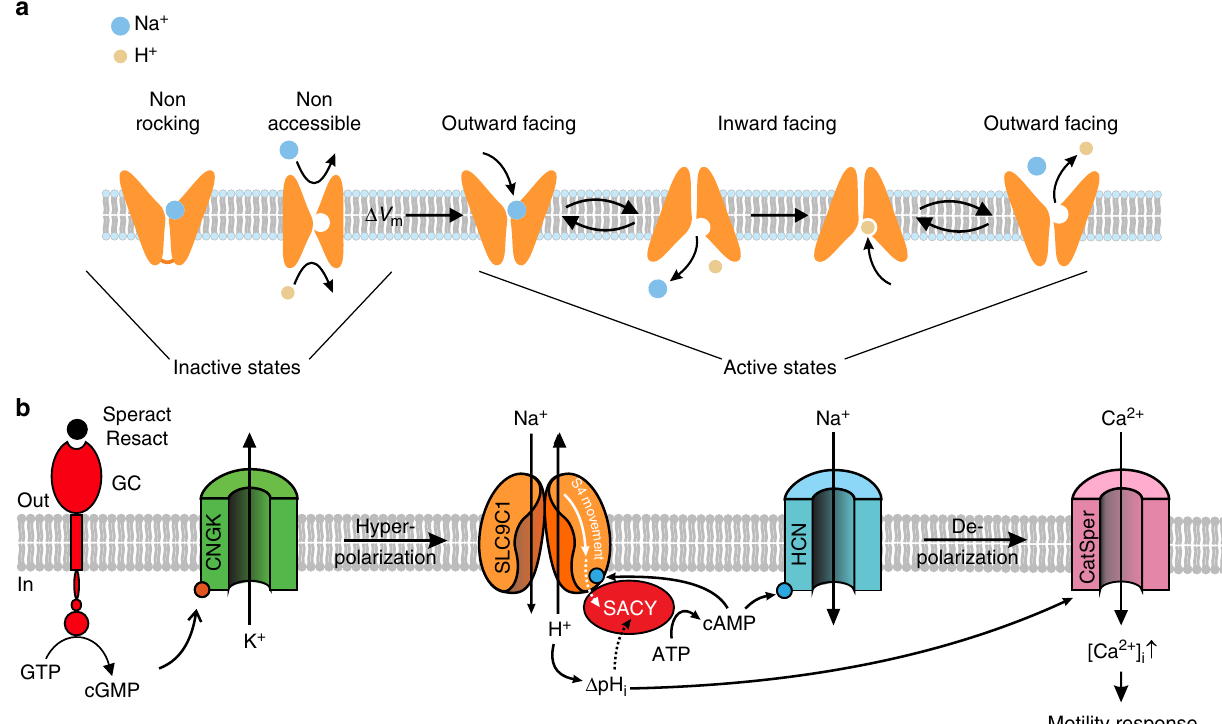
Fig. 7 Models of SLC9C1 gating by voltage and cAMP. a Cartoon depicting that Sp SLC9C1 is active only when the voltage enables its activity. The VSD could gate exchange activity by providing access for ions to their binding sites either by removing a physical gate or by enhancing the binding af fi nity for uploading (non-accessible). Alternatively, in the resting state, ions have access to their binding sites, but the rocking mechanism is locked (non-rocking); voltage unlocks the rocking motion and thus allows switching between outward- and inward facing conformations. b Chemotactic signaling pathway in sea urchin sperm. Chemoattractant binding results in cGMP production and CNGK channel opening. The subsequent hyperpolarization activates SLC9C1. Alkalinization and cAMP production cooperate to open the CatSper channel. The intimate interaction between the exchanger and the soluble adenylate cyclase SACY is of Sp SLC9C1 are missing in mouse and human orthologues (Fig. 1c), suggesting that voltage activation of mammalian SLC9C1 proteins may be different. Thus, our work provides a technical and conceptual blueprint for future studies of mam- malian SLC9C1 orthologues.